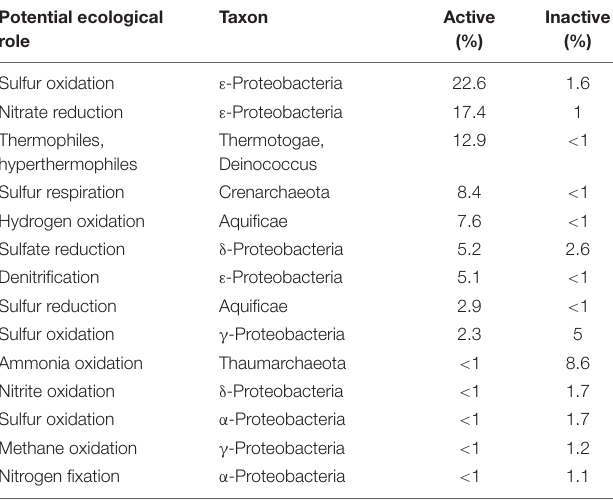
TABLE 2 | Shifts in potentially dominant ecological roles for microbial taxa comprising ≥ 1% of Illumina sequences for active and inactive sulfide samples from the Kolumbo submarine volcano (Hellenic Volcanic